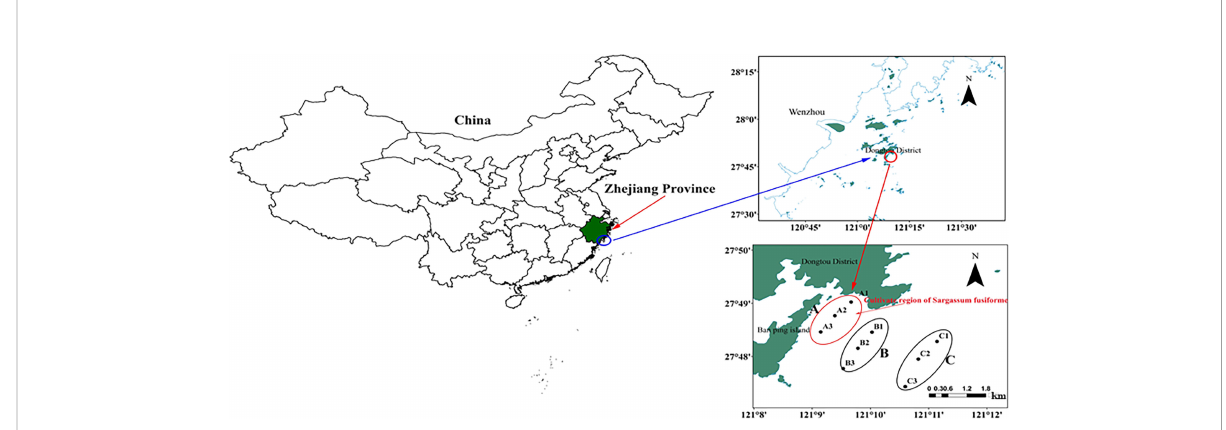
FIGURE 1 Location of sampling sites in Dongtou Island, China. (A) Sargassion fusiforme cultivation area with three sites (A1-A3); (B) adjacent area (without S. fusiforme cultivation) with three sites (B1-B3); (C) open sea area (without S. fusiforme cultivation) with three sites (C1-C3). The depth of each site was showed (A1, A2, A3, B1, B2, B3, C1, C2 and C3:9.6, 9.0.9.8, 9.2, 9.1, 9.4, 9.4, 9.8 and 10.0 m